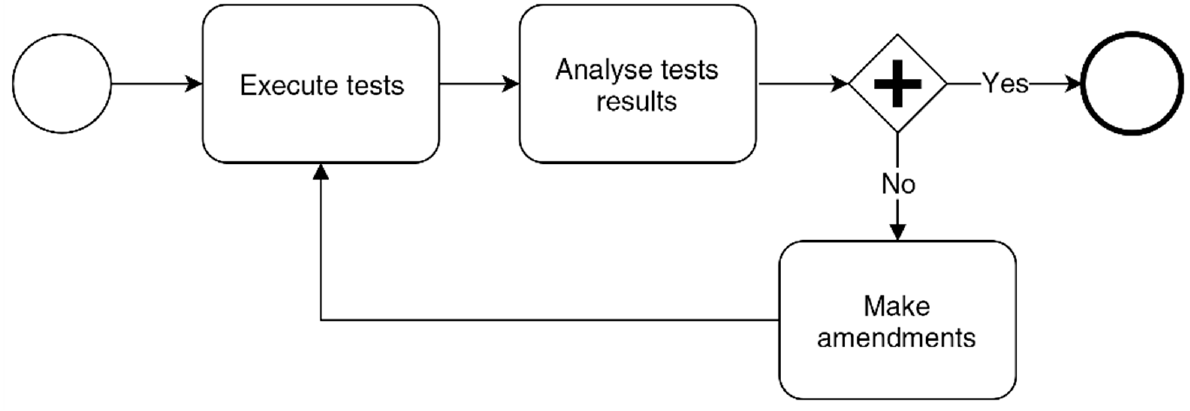
Figure 8. An example of the simplified record creation class.